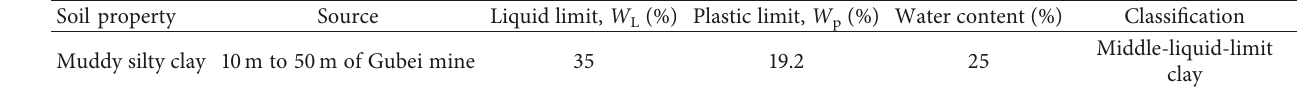
Table 1: Basic physical property of soil samples.